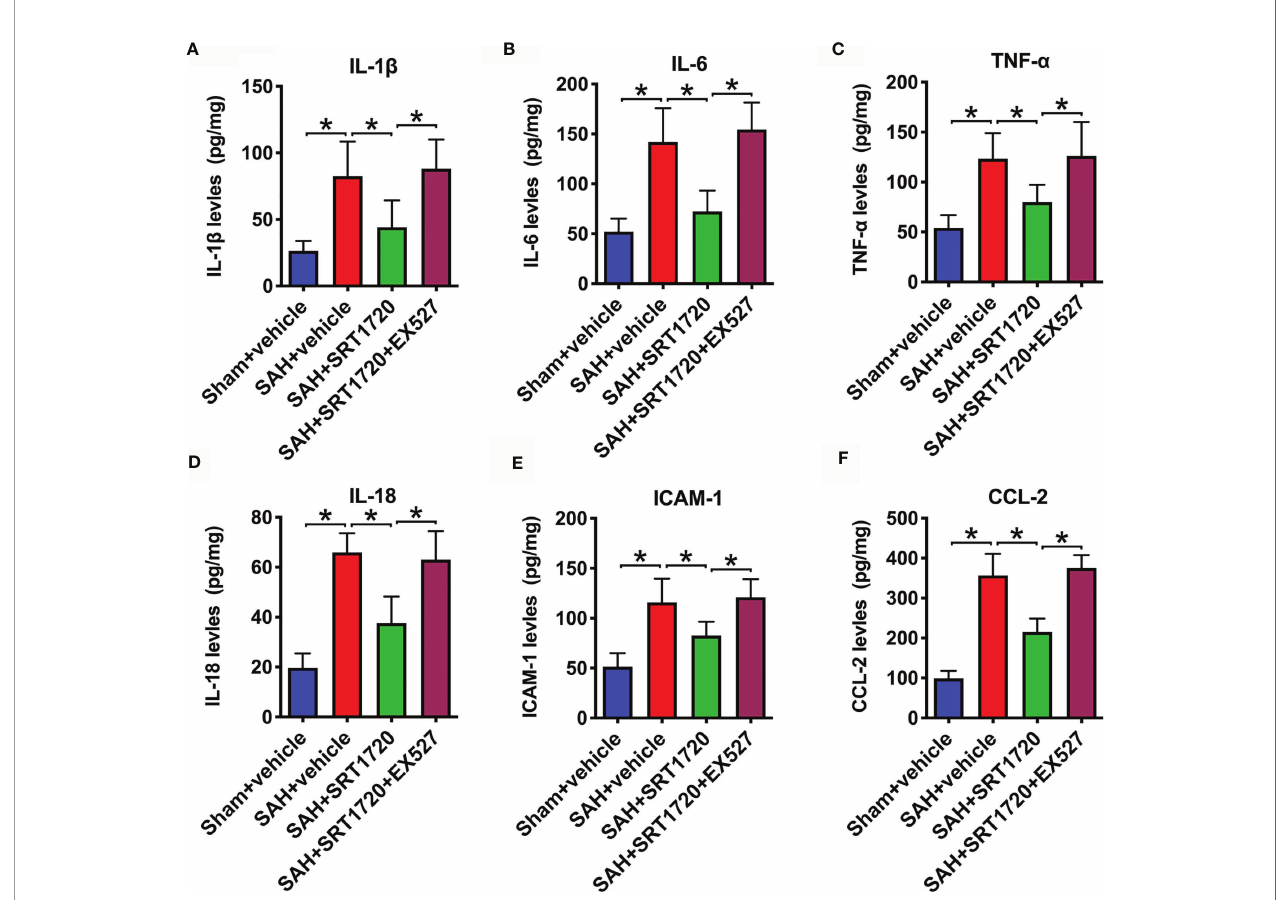
FIGURE 4 | Effects of SRT1720 on in fl ammatory response after SAH. Quanti fi cation of IL-1 b (A) , IL-6 (B) , TNF- a (C) , IL-18 (D) , ICAM-1 (E) , and CCL-2 (F) expressions in all groups. Bars represent the mean ± SD. * P <